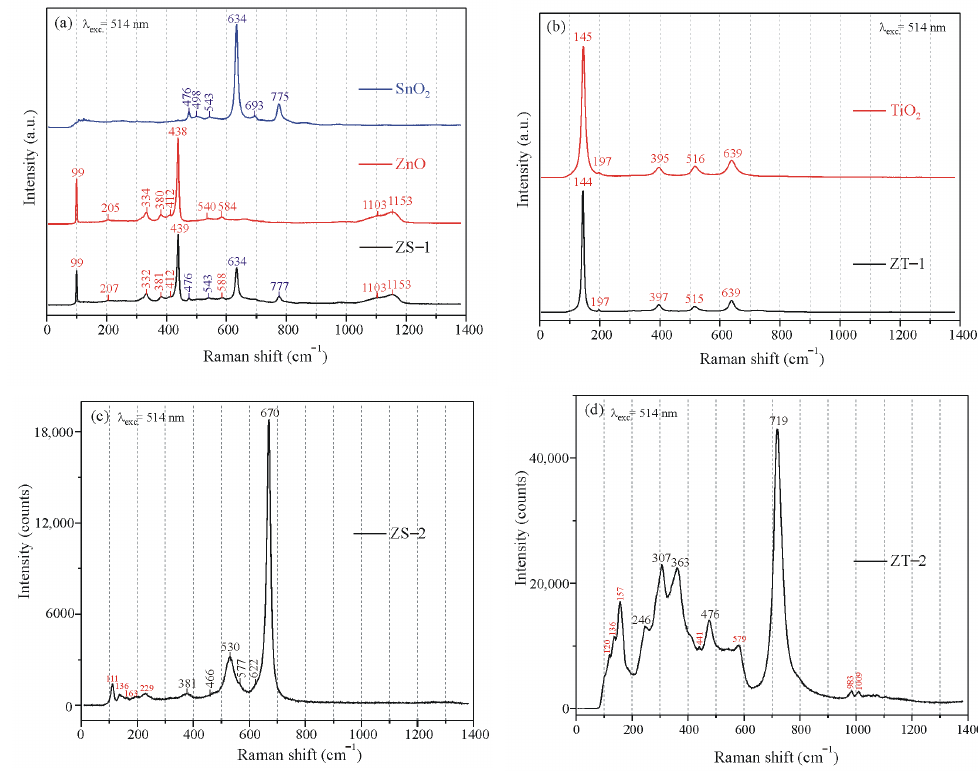
Figure 4. Raman spectra of ( a ) ZS–1 compared to the ZnO and SnO 2 , ( b ) ZT–1 compared to the TiO 2 , ( c ) ZS–2, and ( d )